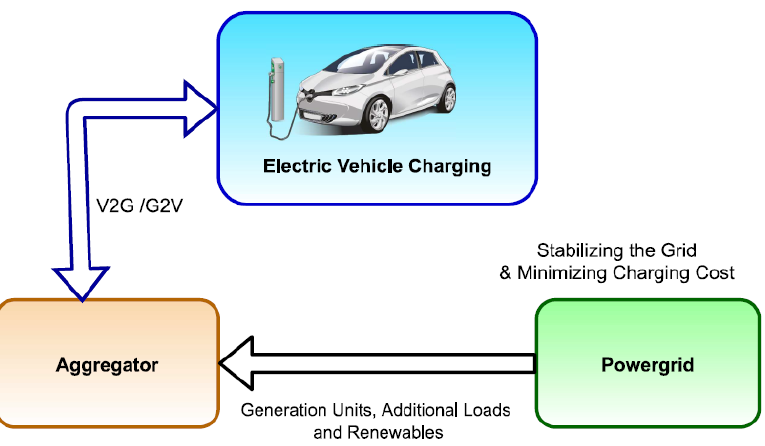
Figure 10. Overview of aggregated storage strategy